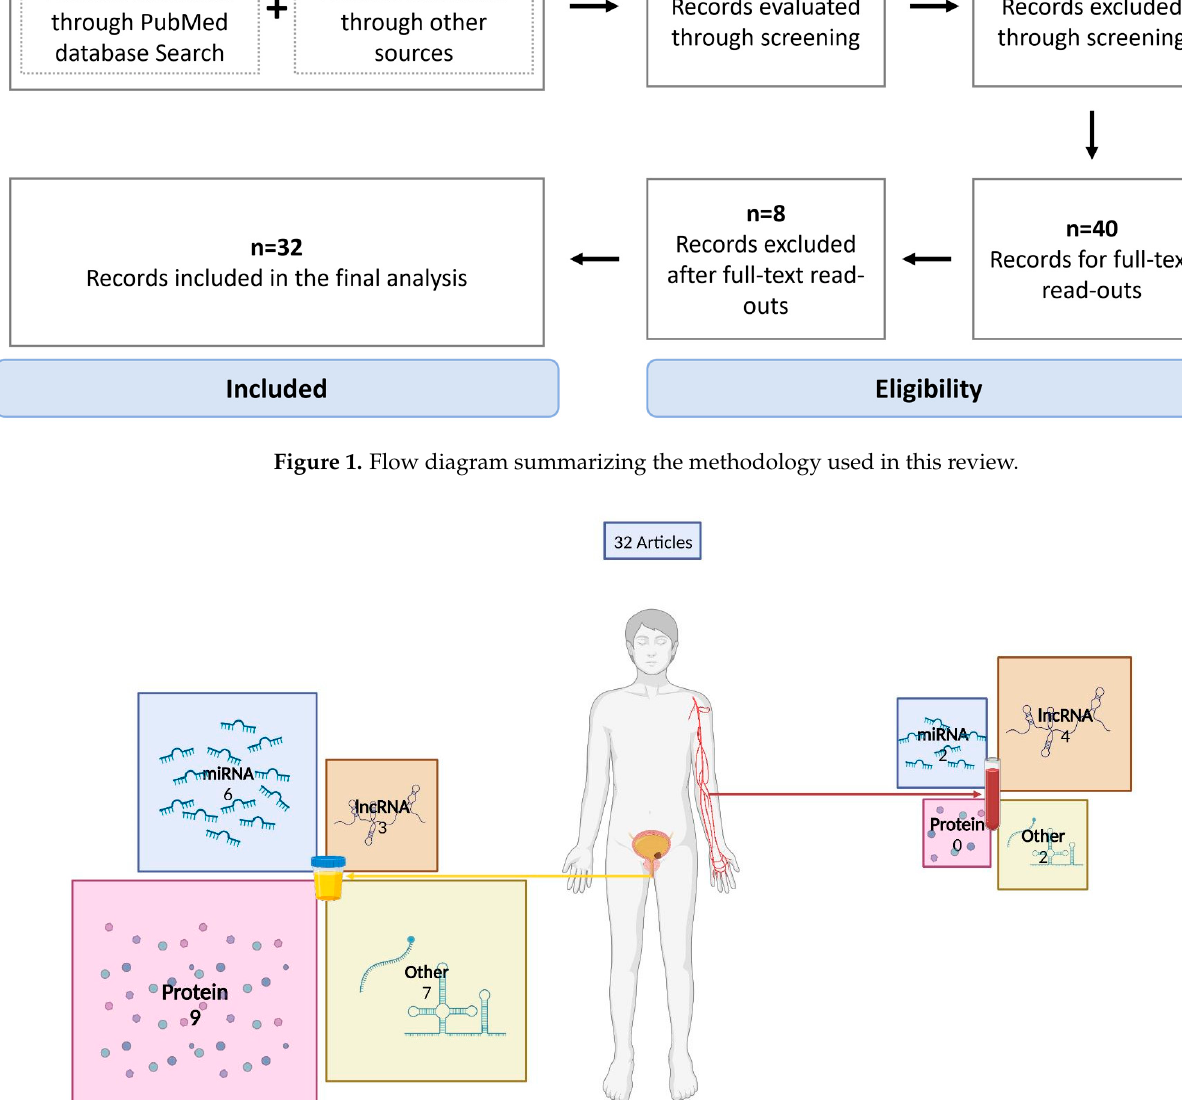
Figure 3. Summary of extracellular vesicle isolation methods that were used in BC articles, concerning urine, plasma, and serum. Numbers represent the number of BC-EV biomarker studies. Abbreviations: BC—Bladder cancer; EVs—extracellular vesicles. Created with BioRender.com. 3. EVs in BC 3.1. miRNA Biomarkers in BC After performing a miRNA array and qRT-PCR analysis in urinary EVs (uEVs), Andreu et al. highlighted miR-375 and miR-146a as diagnostic markers of high-grade and low-grade BC, respectively [55]. Moreover, Matsukazi et al. identi fi ed miR-21-5p as a highly valuable biomarker for BC diagnosis (sensitivity, 75.0%; speci fi city, 95.8%), also